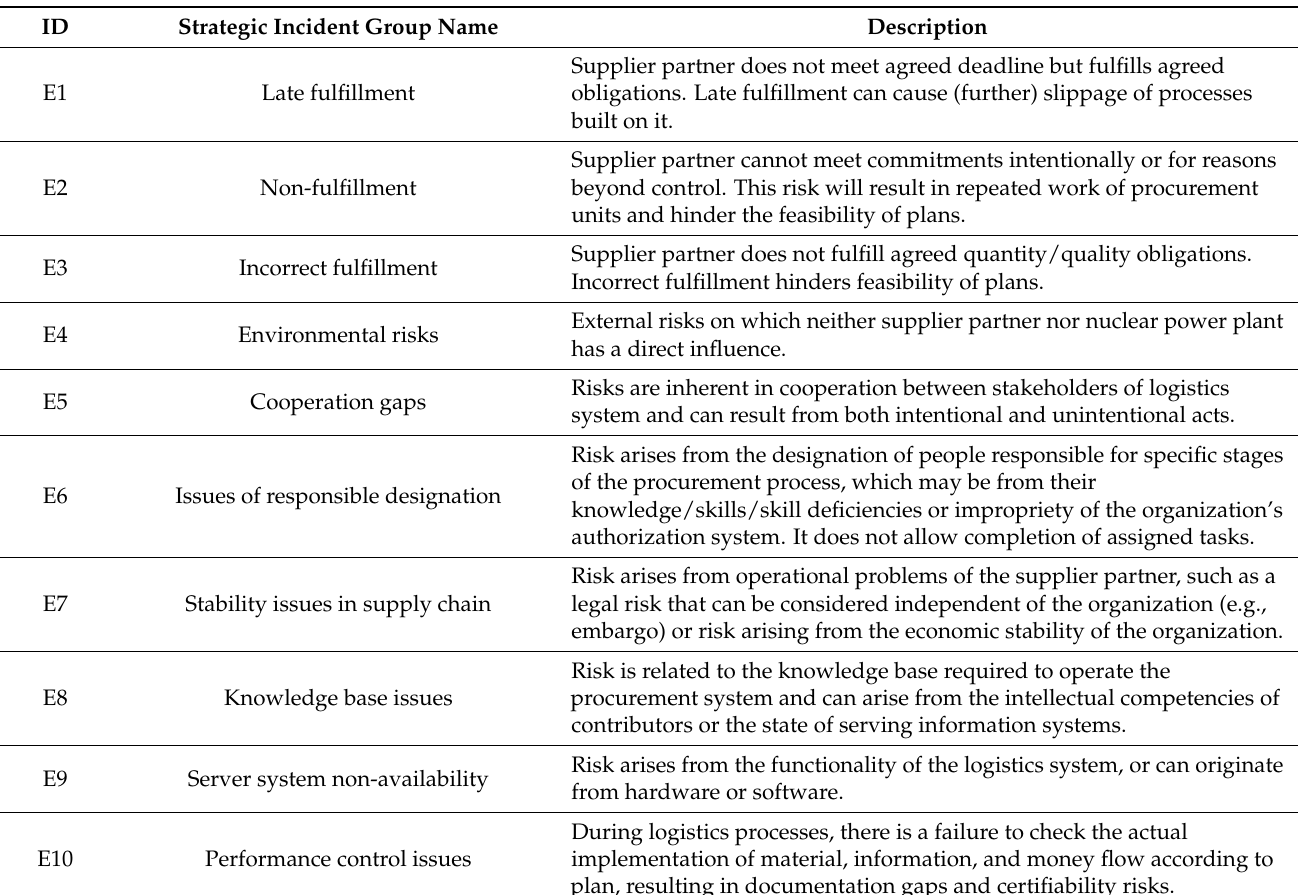
Table A3. List of incident clusters (Bogn á r and Benedek